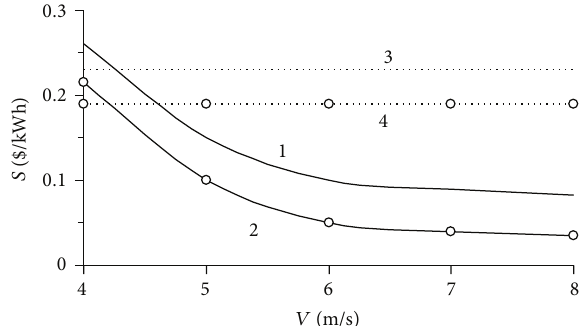
Figure 5: Cost of electricity generated by wind turbines and diesel generators (fuel component at a fuel price of $800/toe) for the scheme in Figure 1: 1: wind turbine (50kW), 2: wind turbine (1000kW), 3: diesel generator (50 kW), 4: diesel generator